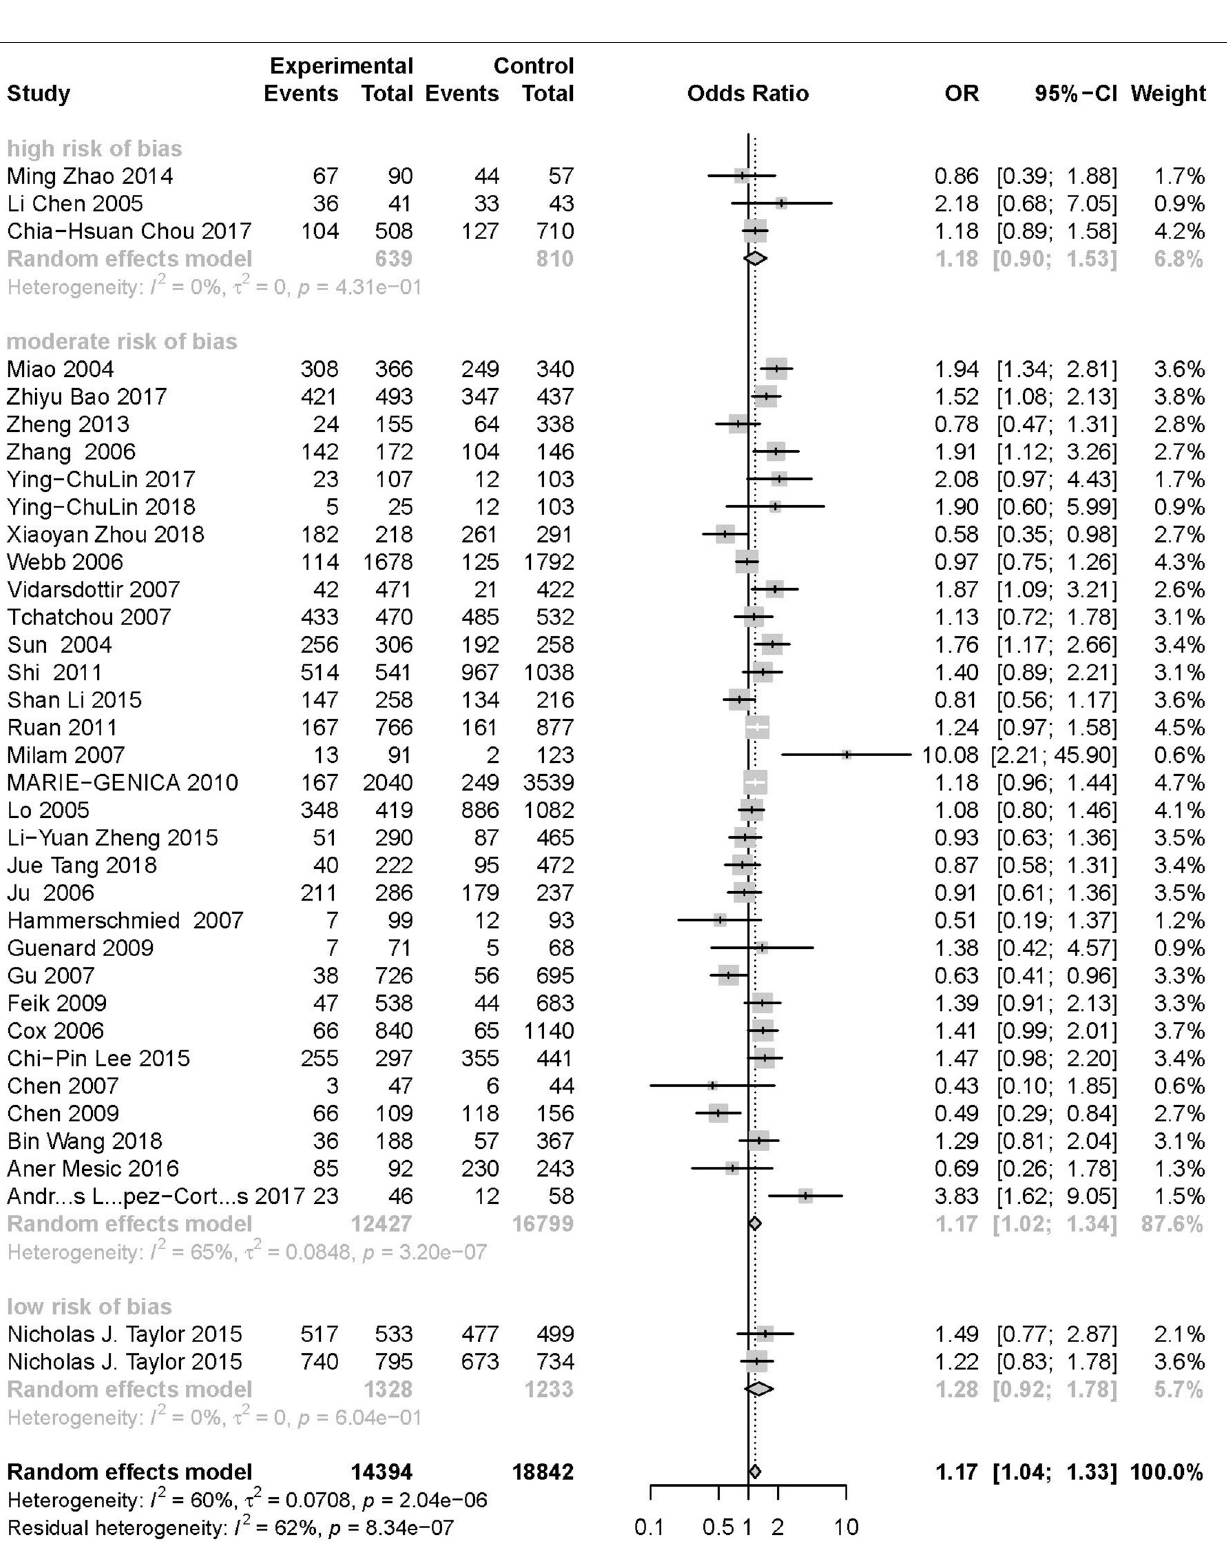
Frontiers in Oncology |